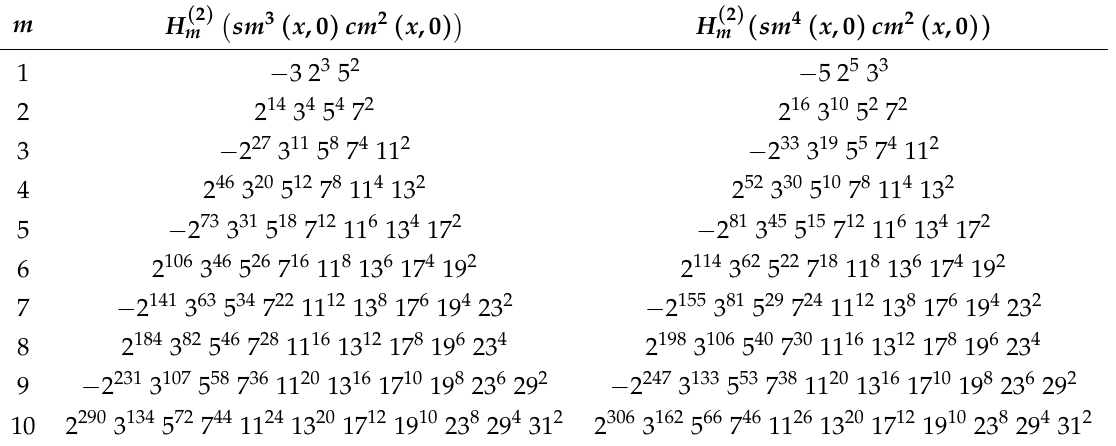
( 2 ) ( . ) of the Dixon elliptic functions sm 3 ( x ,0 ) cm 2 ( x ,0 ) and Hankel determinants H m sm 4 ( x ,0 ) cm 2 ( x ,0 ) for m from